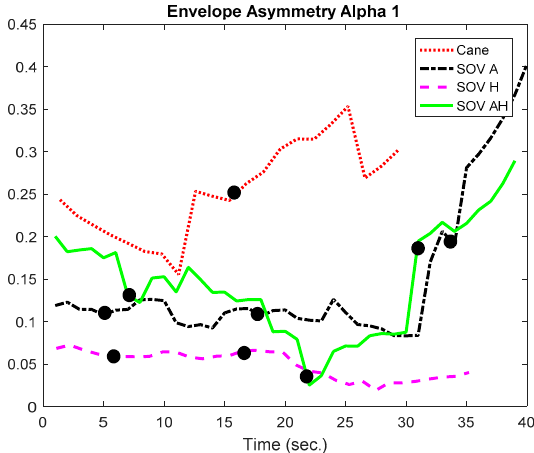
Figure 20. The envelopes of the alpha1 asymmetries for a late-blind user.